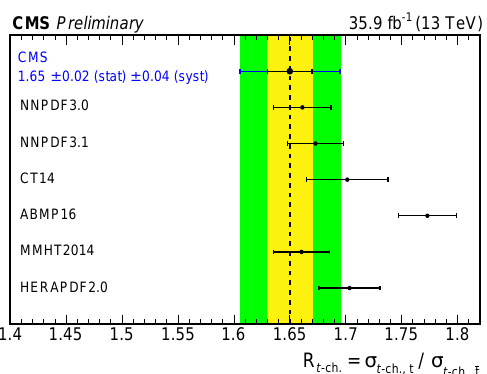
Figure 9. Comparison of the measured R t − ch . (dotted line) with the prediction from different PDF sets [29].